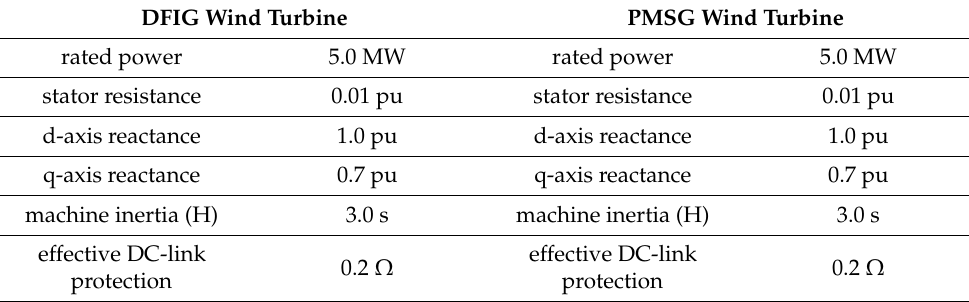
Figure 7. DFIG wind turbine model with the fault current limiters. Table 1. Rating of parameters of the wind turbines.